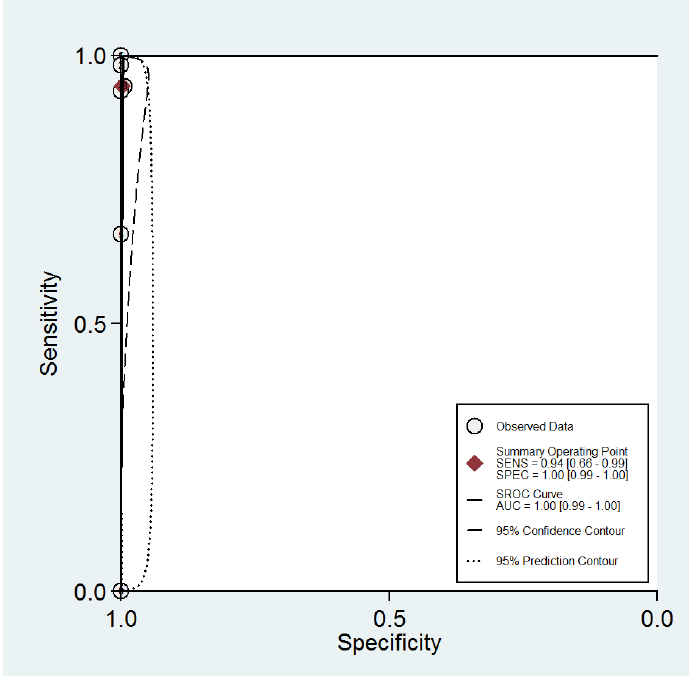
Figure 5. Summary ROC curve for the diagnostic performance of two-dimensional sonohysterogra- phy to detect uterine septum, showing the sensitivity and specificity for each study and pooled estimation. The dashed line around the summary point estimate (red diamond) represents the 95% confidence region. The dotted line showing the 95% prediction contour corresponds to the predicted performance taking into account all individual studies.